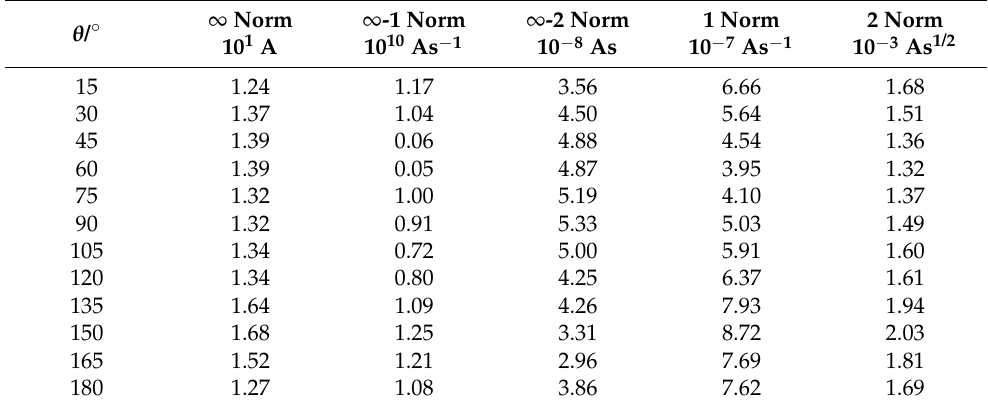
Table 2. The values calculated by different norms with different θ of both the 0 to 180 ns period waveforms and the entire waveforms.